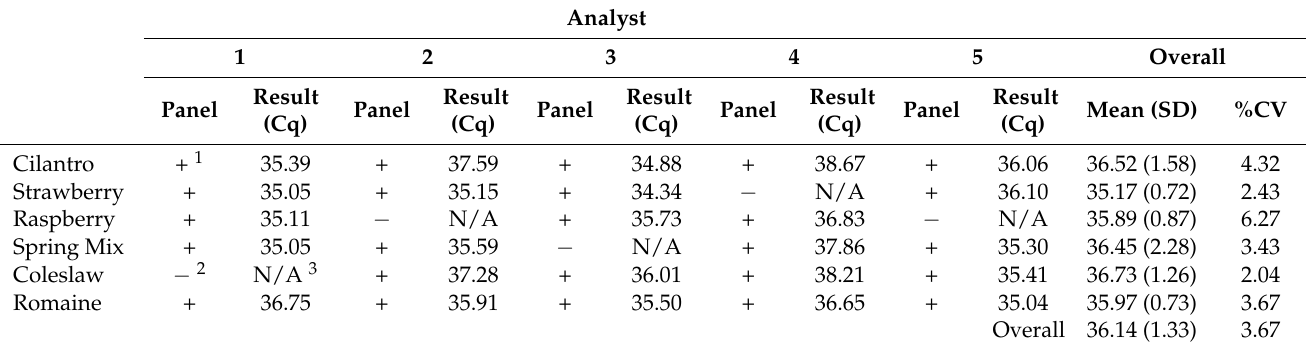
Table 6. Cq values for proficiency panels run by five different analysts.